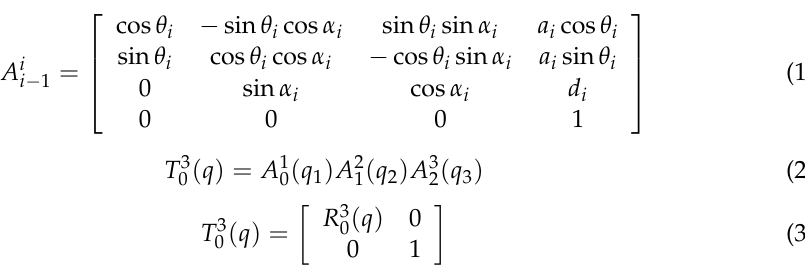
Figure 2. Axes of the joint coordinate